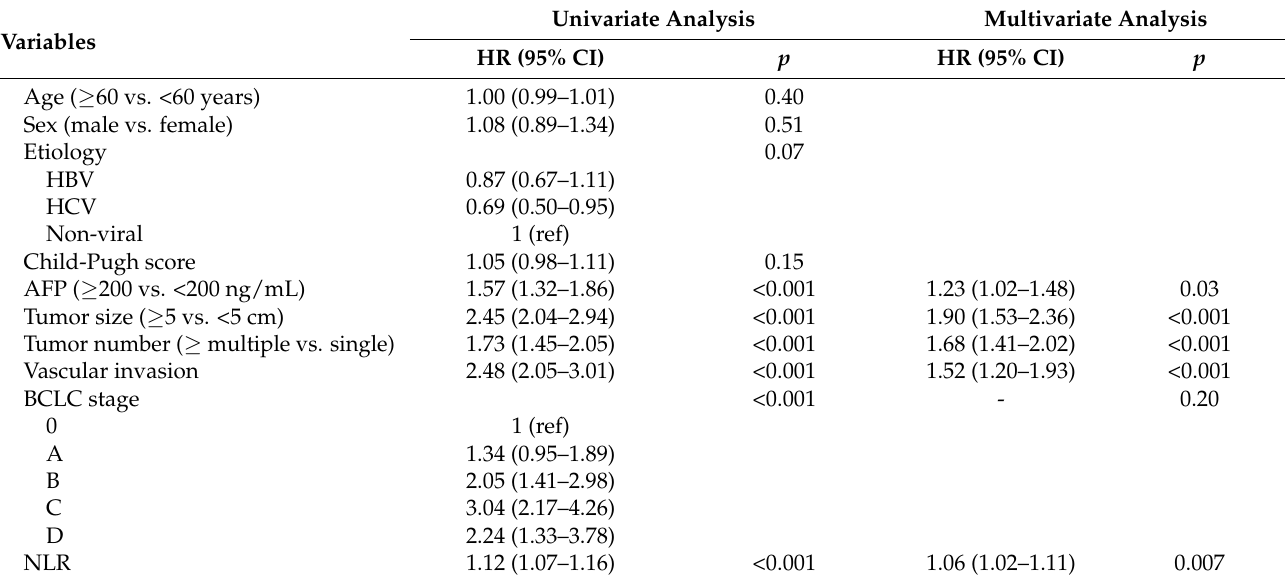
Table 2. Univariate and multivariate analyses of factors associated with